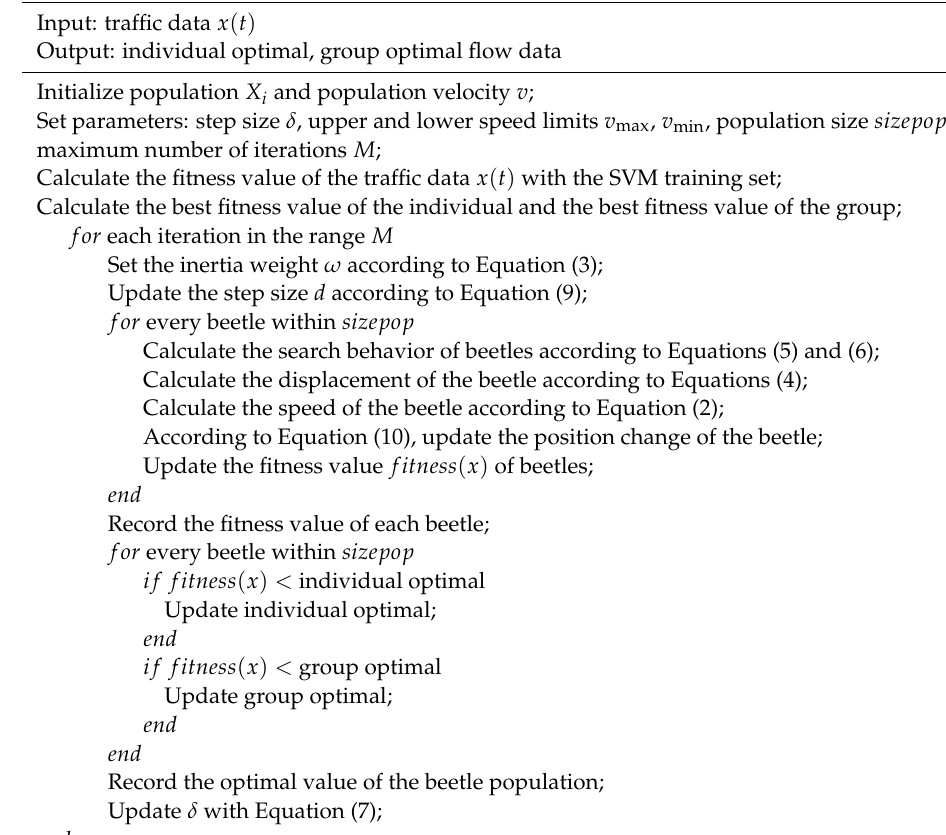
Algorithms 2 : Network traffic prediction algorithm based on improved BSO optimized